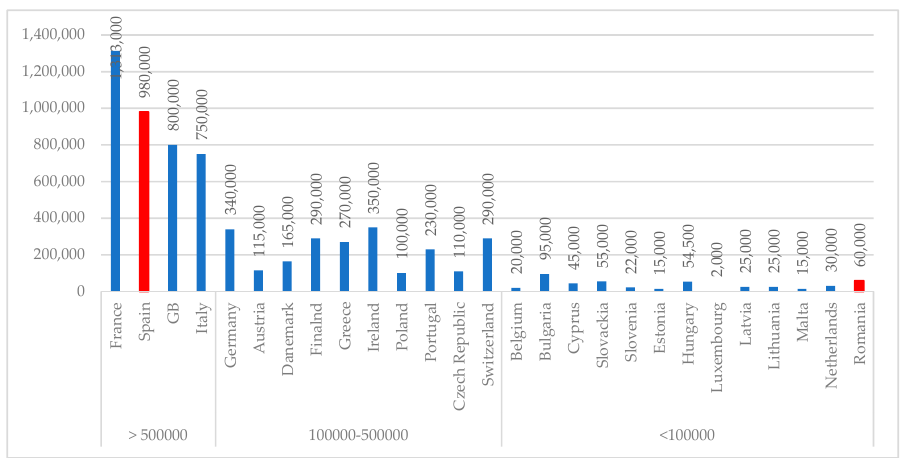
Figure 1. Number of hunters in Europe in 2017.